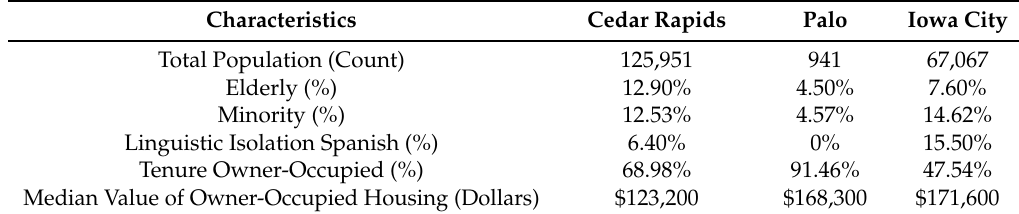
Table 1. Characteristics of study